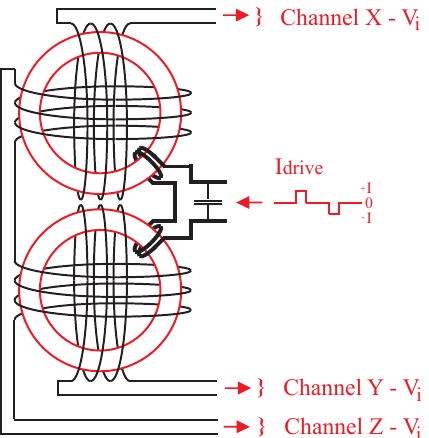
Fig. 3. Schematic of one fluxgate component showing the major components. The FPGA controller generates a 28800Hz drive sig- nal that is power amplified (PA) and sent into the drive winding to periodically saturate and and unsaturate the ring cores. The band- pass, phase synchronous detector, low pass, and integrator hard- ware in a classic 2 f fluxgate are replaced with a current-to-voltage converter (I/V) and an ADC to digitise the signal. An FPGA uses the fluxgate signal as the input to a control loop to drive the mag- netic field in the sensor towards zero. The output of the control loop is converted to an analog signal (DAC) and then to a high- precision, temperature compensated current to provide magnetic feedback (V/I).